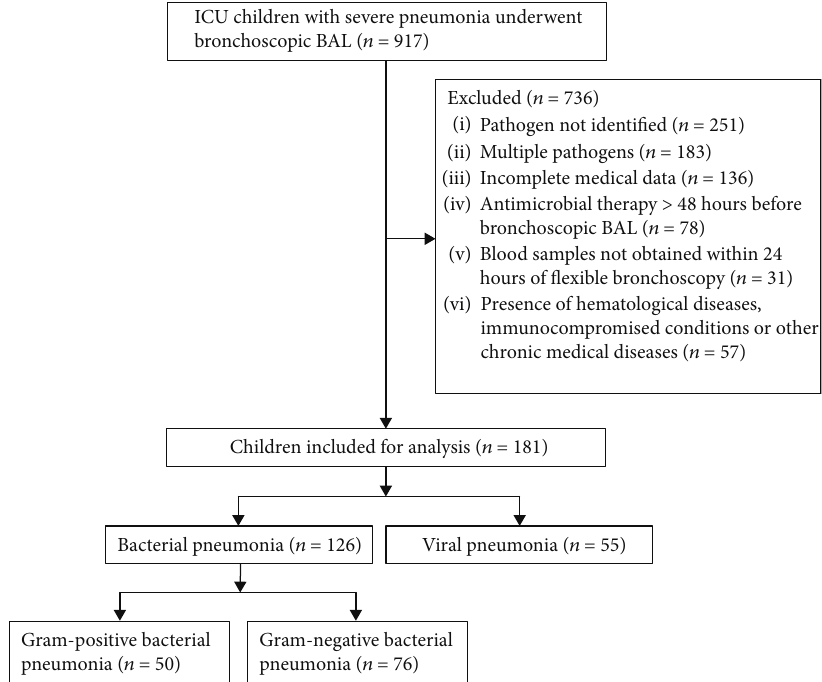
Figure 1: Flowchart of the child selection process for analysis. ICU: intensive care unit; BAL: bronchoalveolar